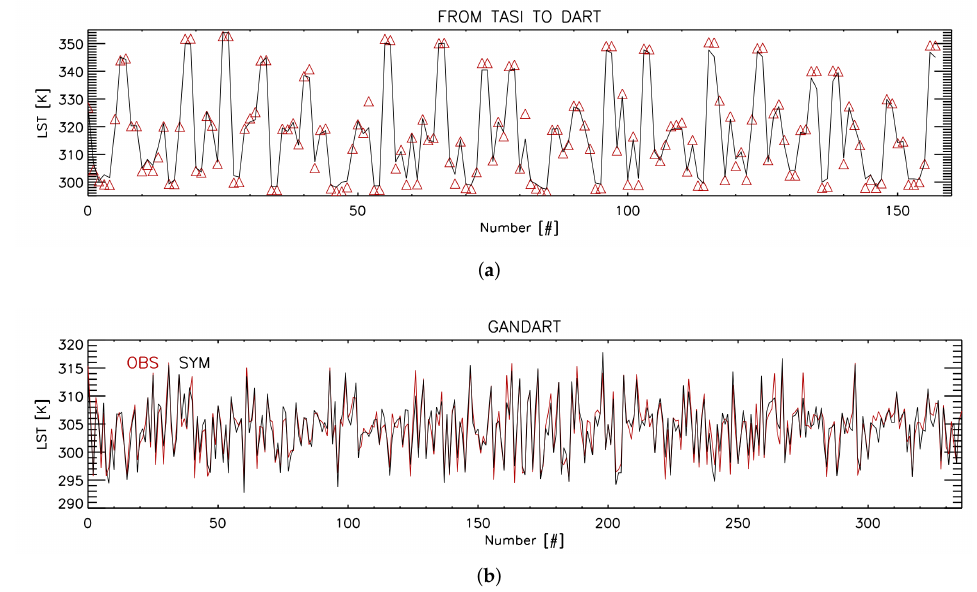
Figure 1. ( a ) Reduced least-square fit of LST retrieved from TASI-to-DART for GSW coefficients calculated using a part of the from-TASI-to-DART dataset. ( b ) Reduced least-square fit of LST retrieved from TASI for GSW coefficients calculation using GANDART features. Observations in red, simulations in